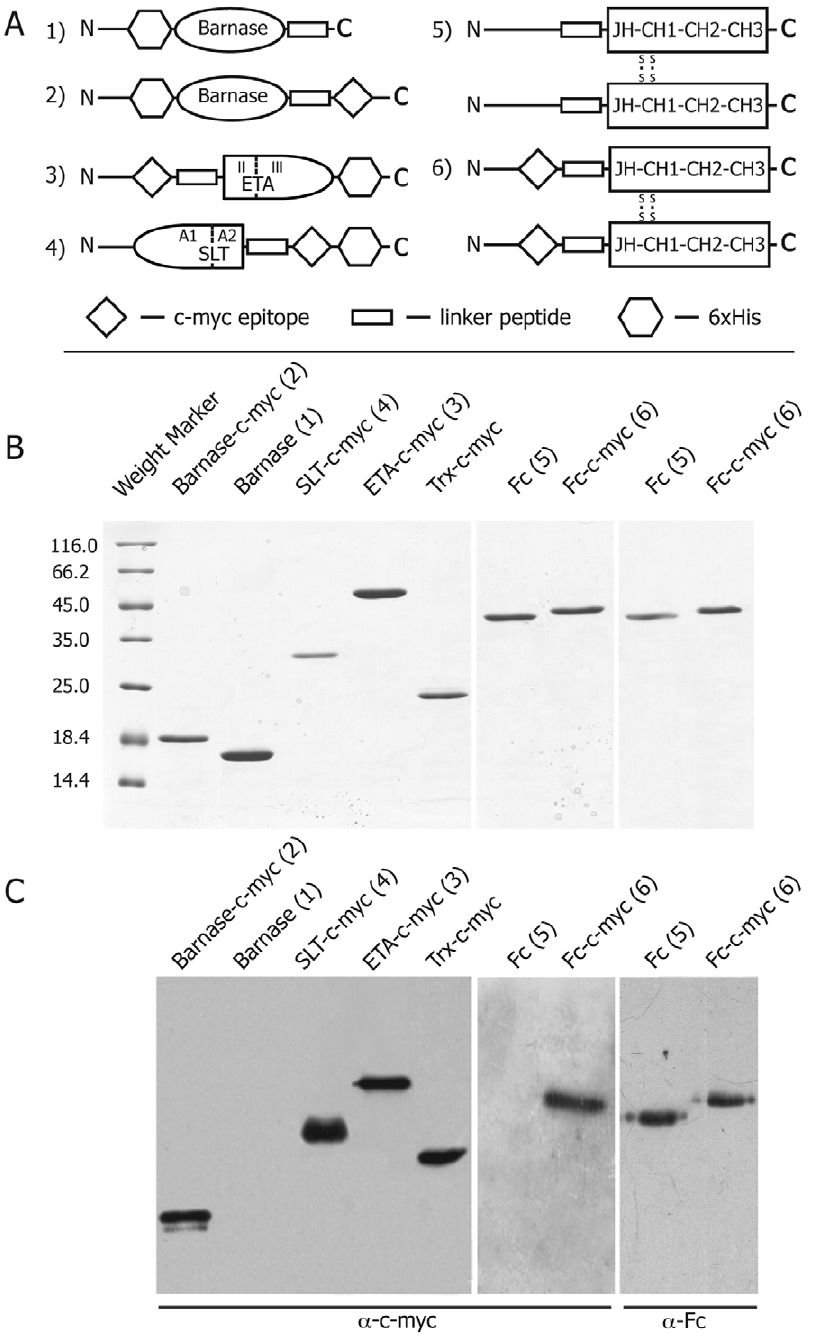
Figure 1. Construction and purification of recombinant IT. (A) Schematic representation of the designed ITs, fused with c-myc epitope sequence, based on barnase (1 and 2), catalytic (III) and translocation (II) domains of Pseudomonas toxin ETA (3), catalytic (A1) and binding (A2) domains of Shiga-like toxin E.coli (4) and Fc domain of human antibody IgG c 1 (5 and 6). (B) The purity of prepared recombinant molecules was confirmed by 12% SDS-PAGE. (C) The presence of the c-myc epitope was shown by hybridization of recombinant ITs with anti-c-myc mAbs, produced by selected hybridoma.